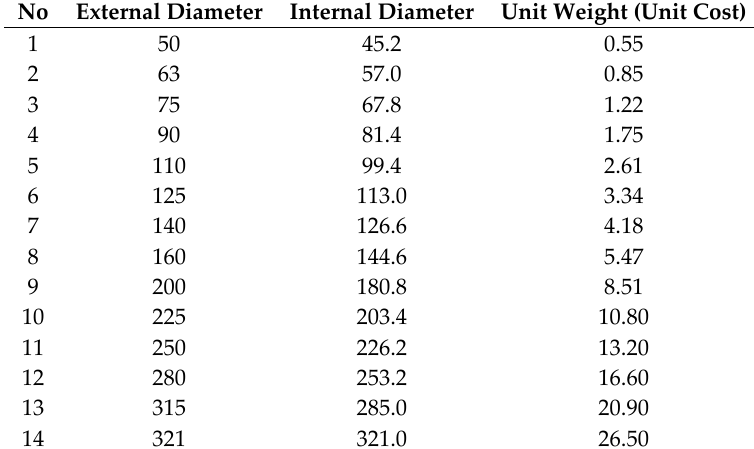
Table 2. Available commercial diameters.